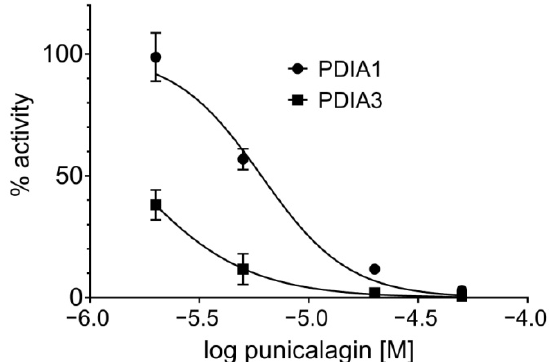
Figure 4. Dose-response curve of punicalagin showing the inhibition of PDIA1 and PDIA3 reductase activity using di-E-GSSG as substrate. Each point represents the average of at least three independent measurements. PDIA1, IC 50 = 6.1 µM, 95% confidence from 5.5 to 6.7 µM; PDIA3, IC50 = 1.5 µM, 95% confidence from 1.3 to 1.6 µM).